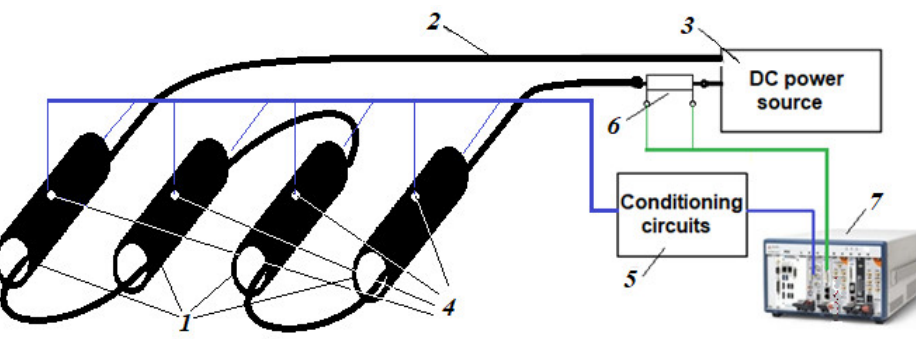
Figure 1. The cables in casing pipes buried in the trench.